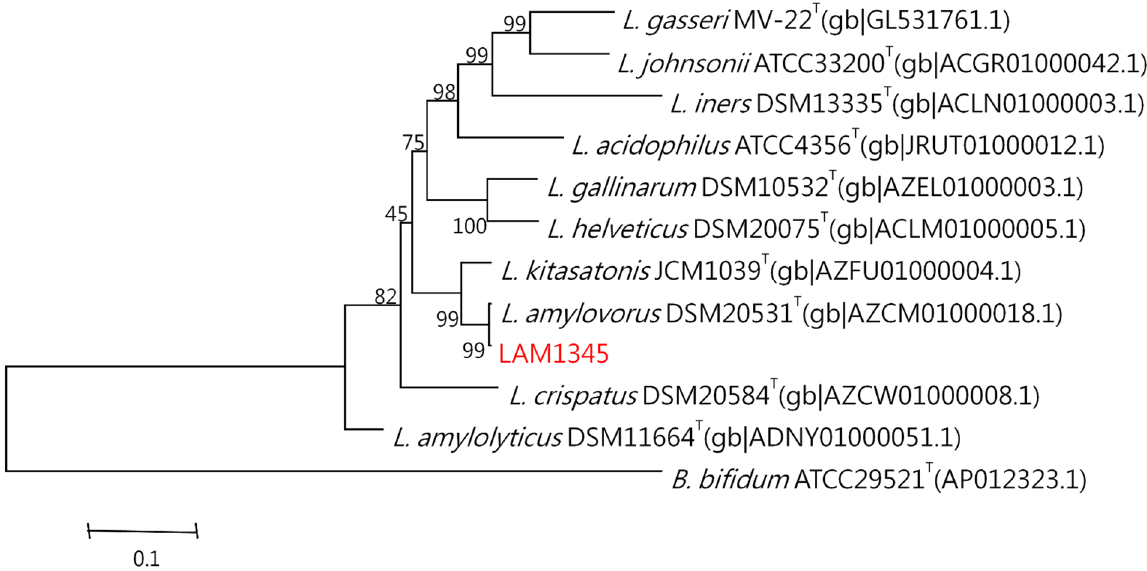
Figure 5. Phylogenetic tree based on the 16S rRNA gene sequence showing the phylogenetic relationships between the LAM1345 strain and related lactobacilli species.